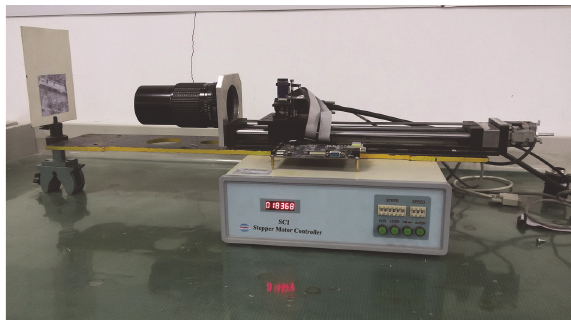
Figure 10: The autofocusing experiment system.